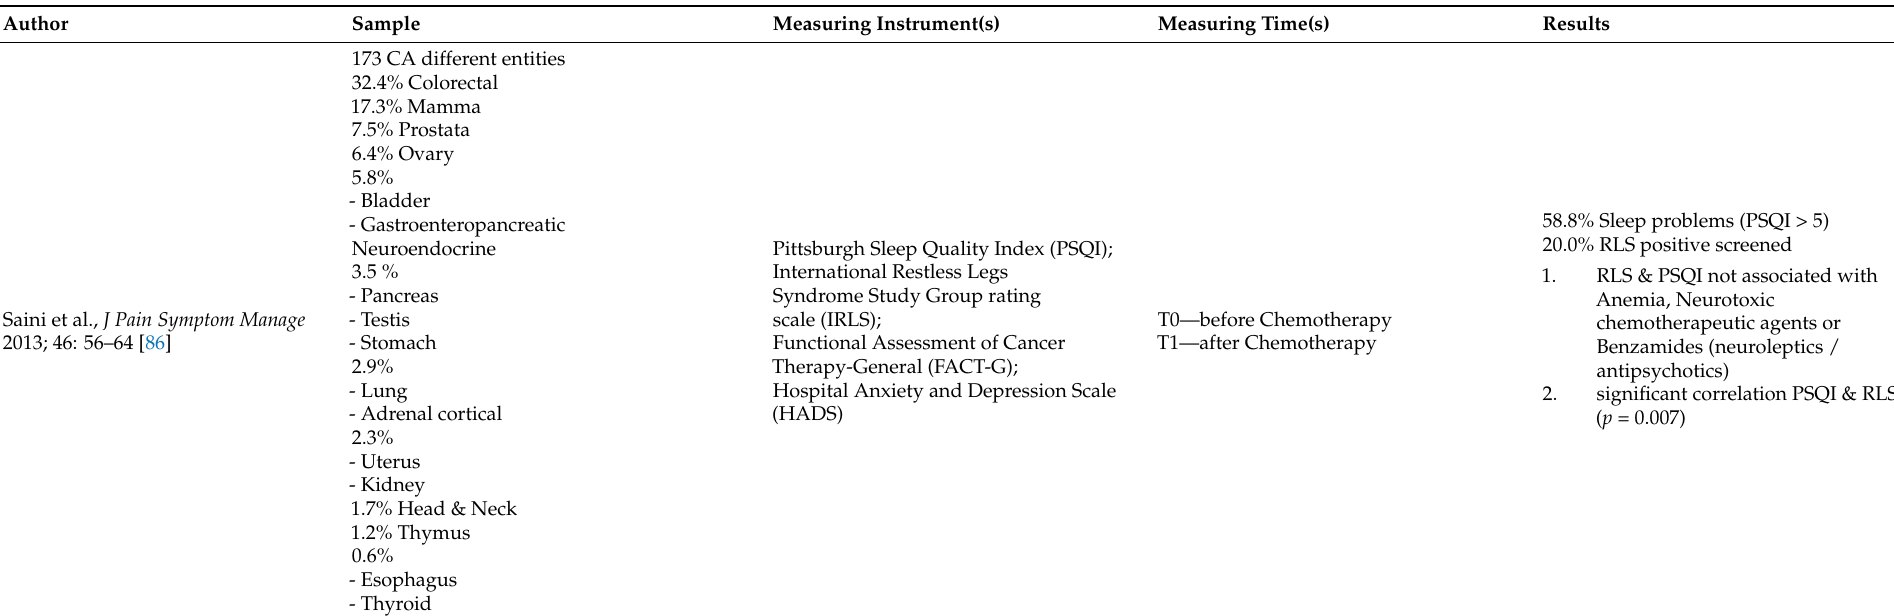
Table 8. Studies on Restless Legs Syndrome (RLS) in